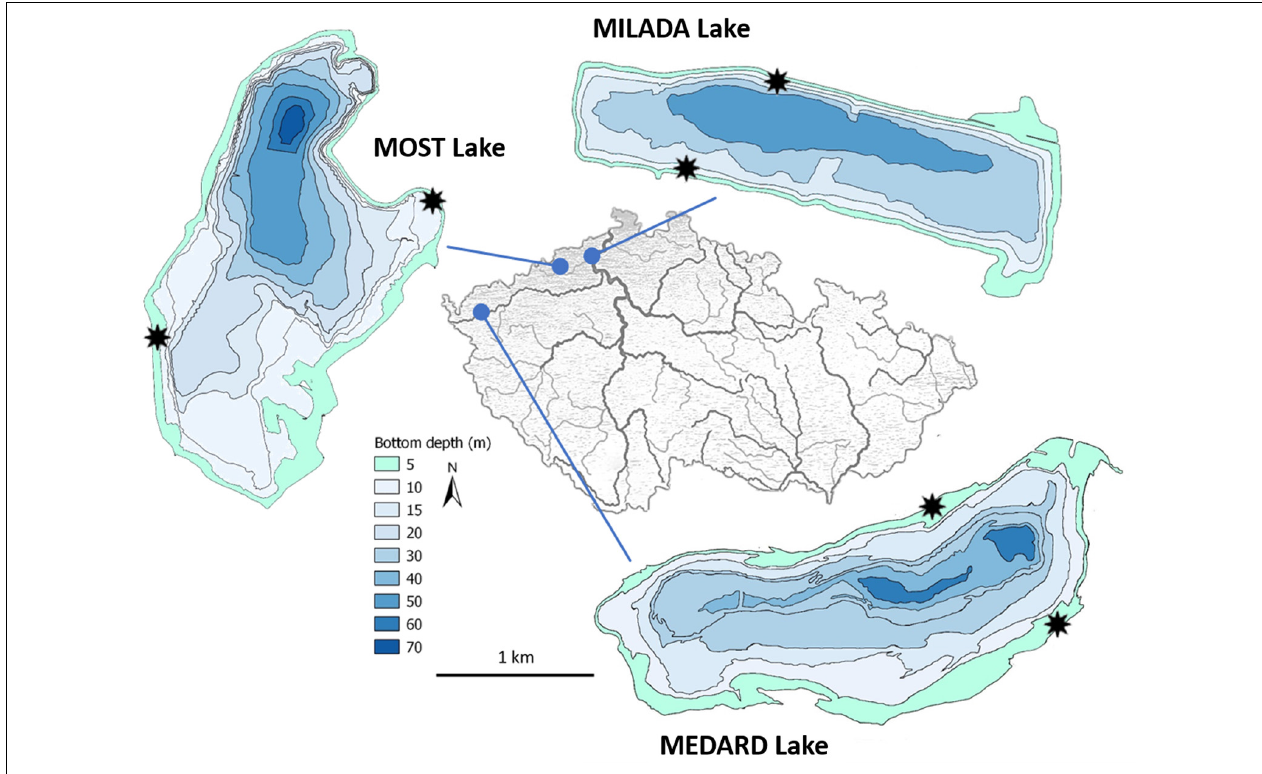
FIGURE 1 | Maps of the investigated post-mining lakes and location of the sampling sites (asterisks). TABLE 1 | Chemical and limnological parameters of the three post-mining lakes in the Czech Republic sampled from the depth of 0.5 m at their deepest points in 2019. Lake